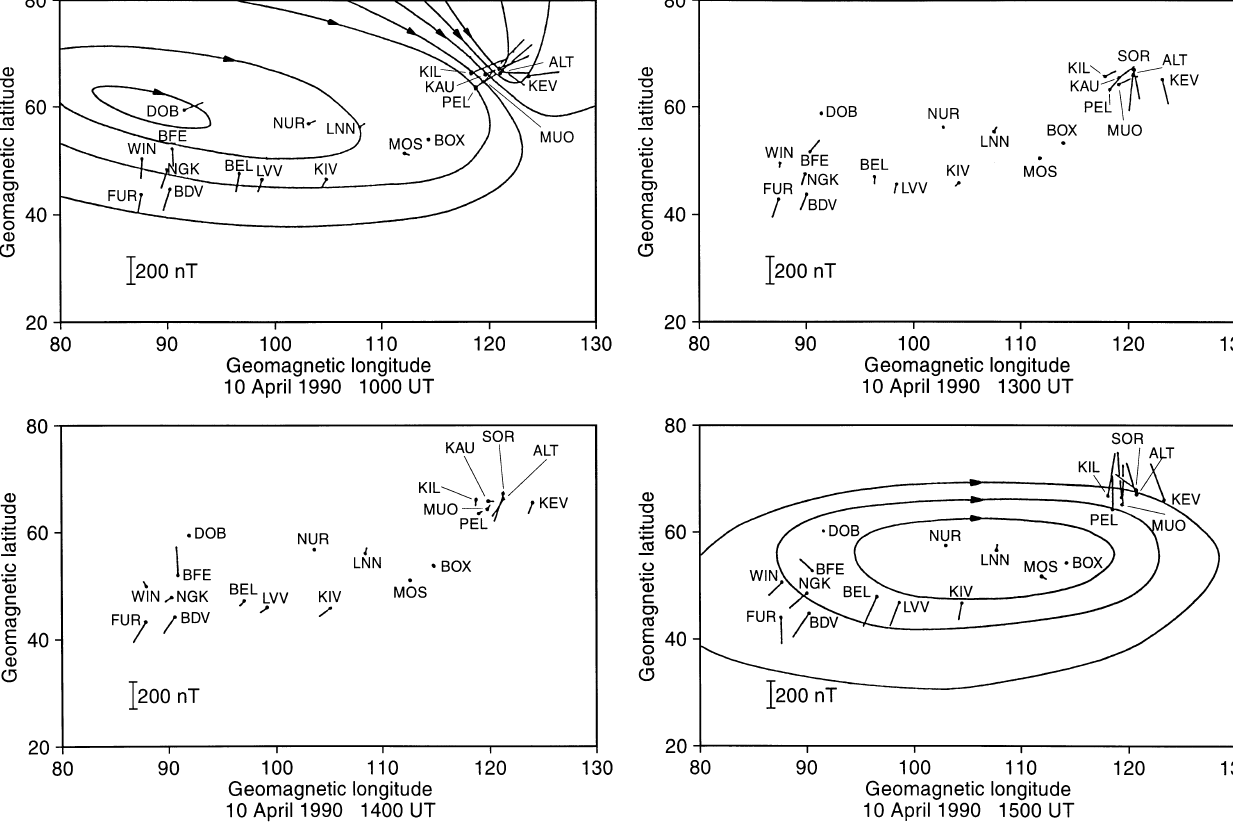
Fig. 9. Horizontal magnetic disturbance vectors and the equivalent ionospheric current system, respectively, for di(cid:128)erent time moments on 10